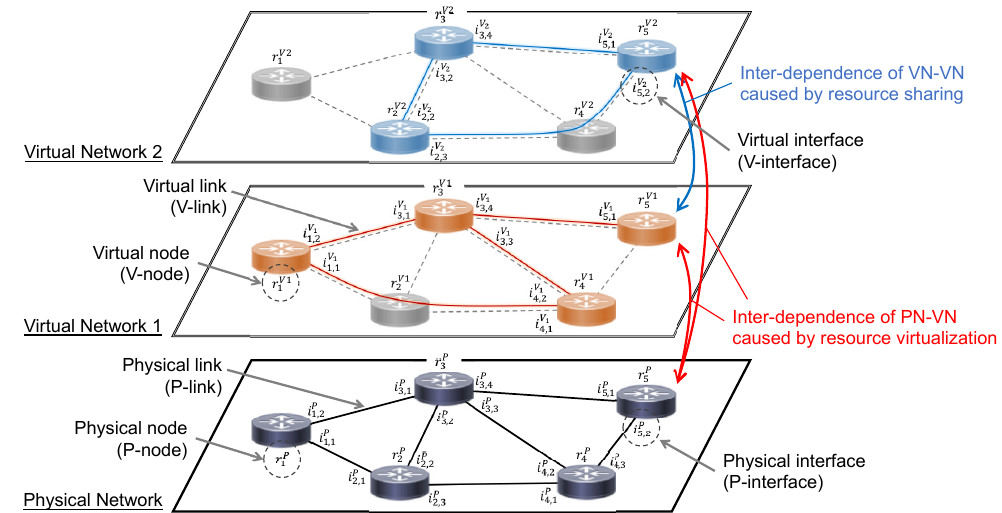
Figure 3. Example of virtualized network based on network slicing.